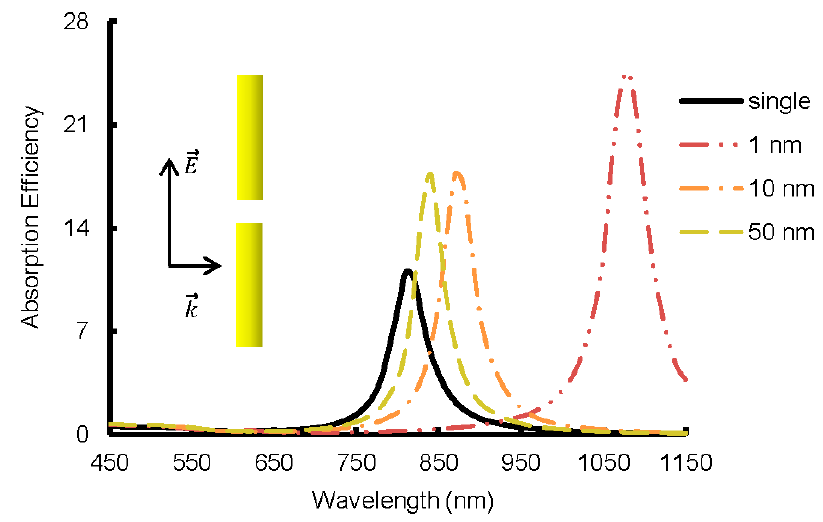
Figure 10. Absorption efficiency of end-to-end assembly with various gaps.